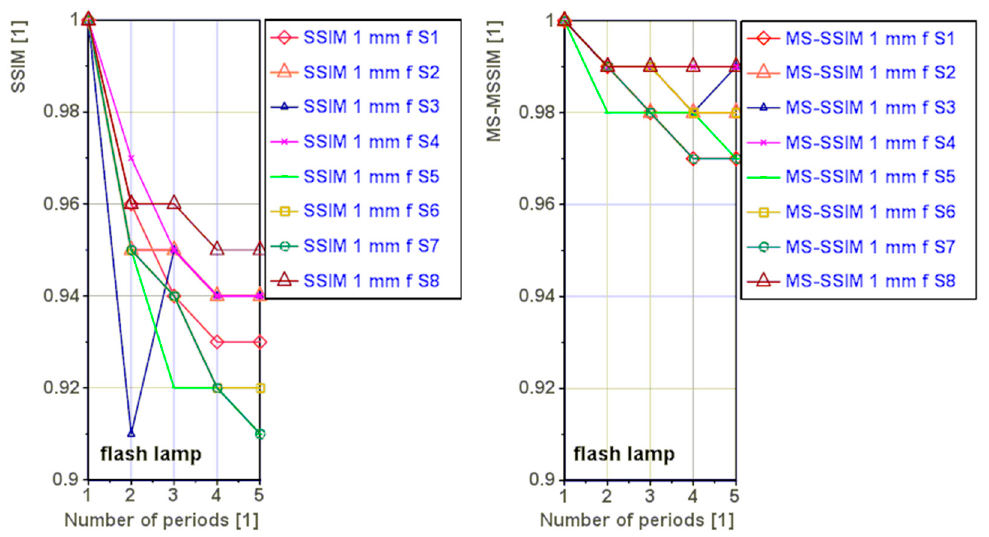
Figure 7. Variation of the SSIM and MS-SSIM index values as a function of the number of periods for the flash lamp.